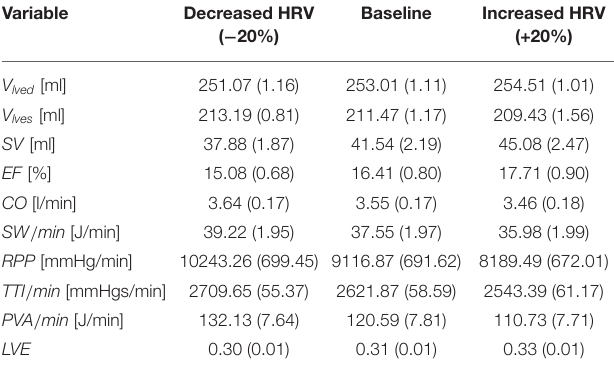
TABLE 5 | Heart failure.